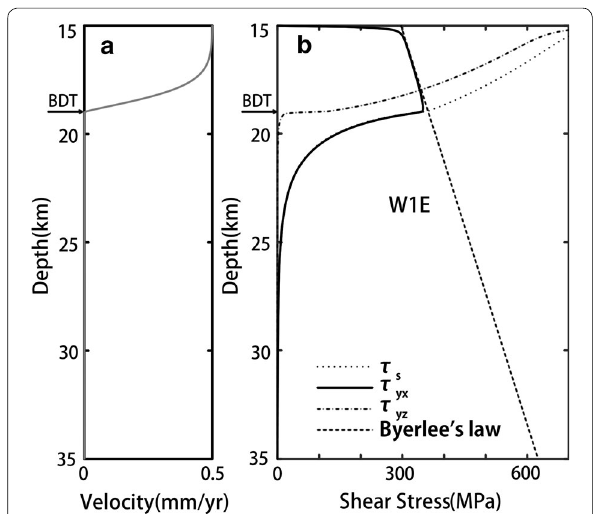
Fig. 3 a Fault slip velocity ( v ) and b shear stress on the bilateral symmetry line in the lower crust for model W1E. τ s is the second deviatoric stress invariant; τ yx and τ yz are the yx and yz components of shear stress, respectively; and the straight broken line is based on Byerlee’s law. The depth of the BDT is shown by black